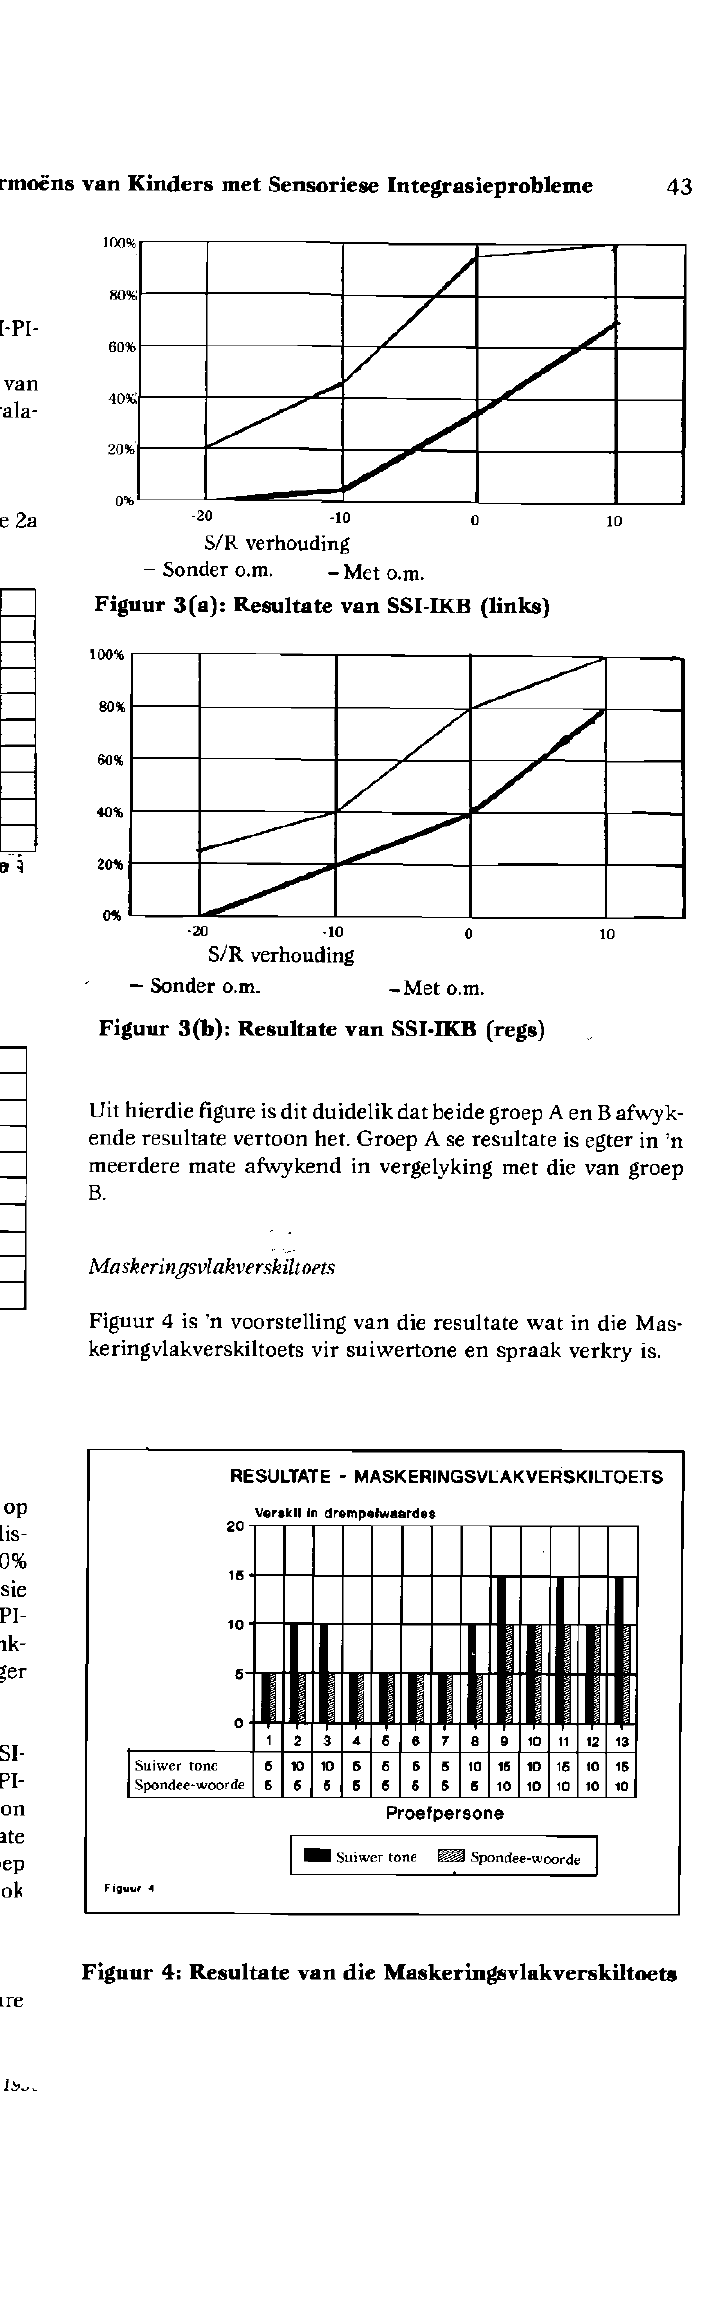
Die Suid-Afrikaanse Tydskrif vir Kommunikasieafivykinfls, Vol. 37,